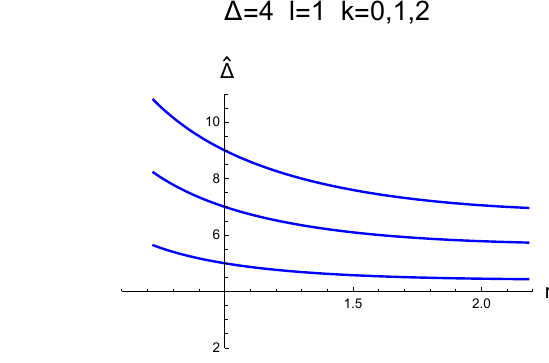
(cid:1) as a function of b